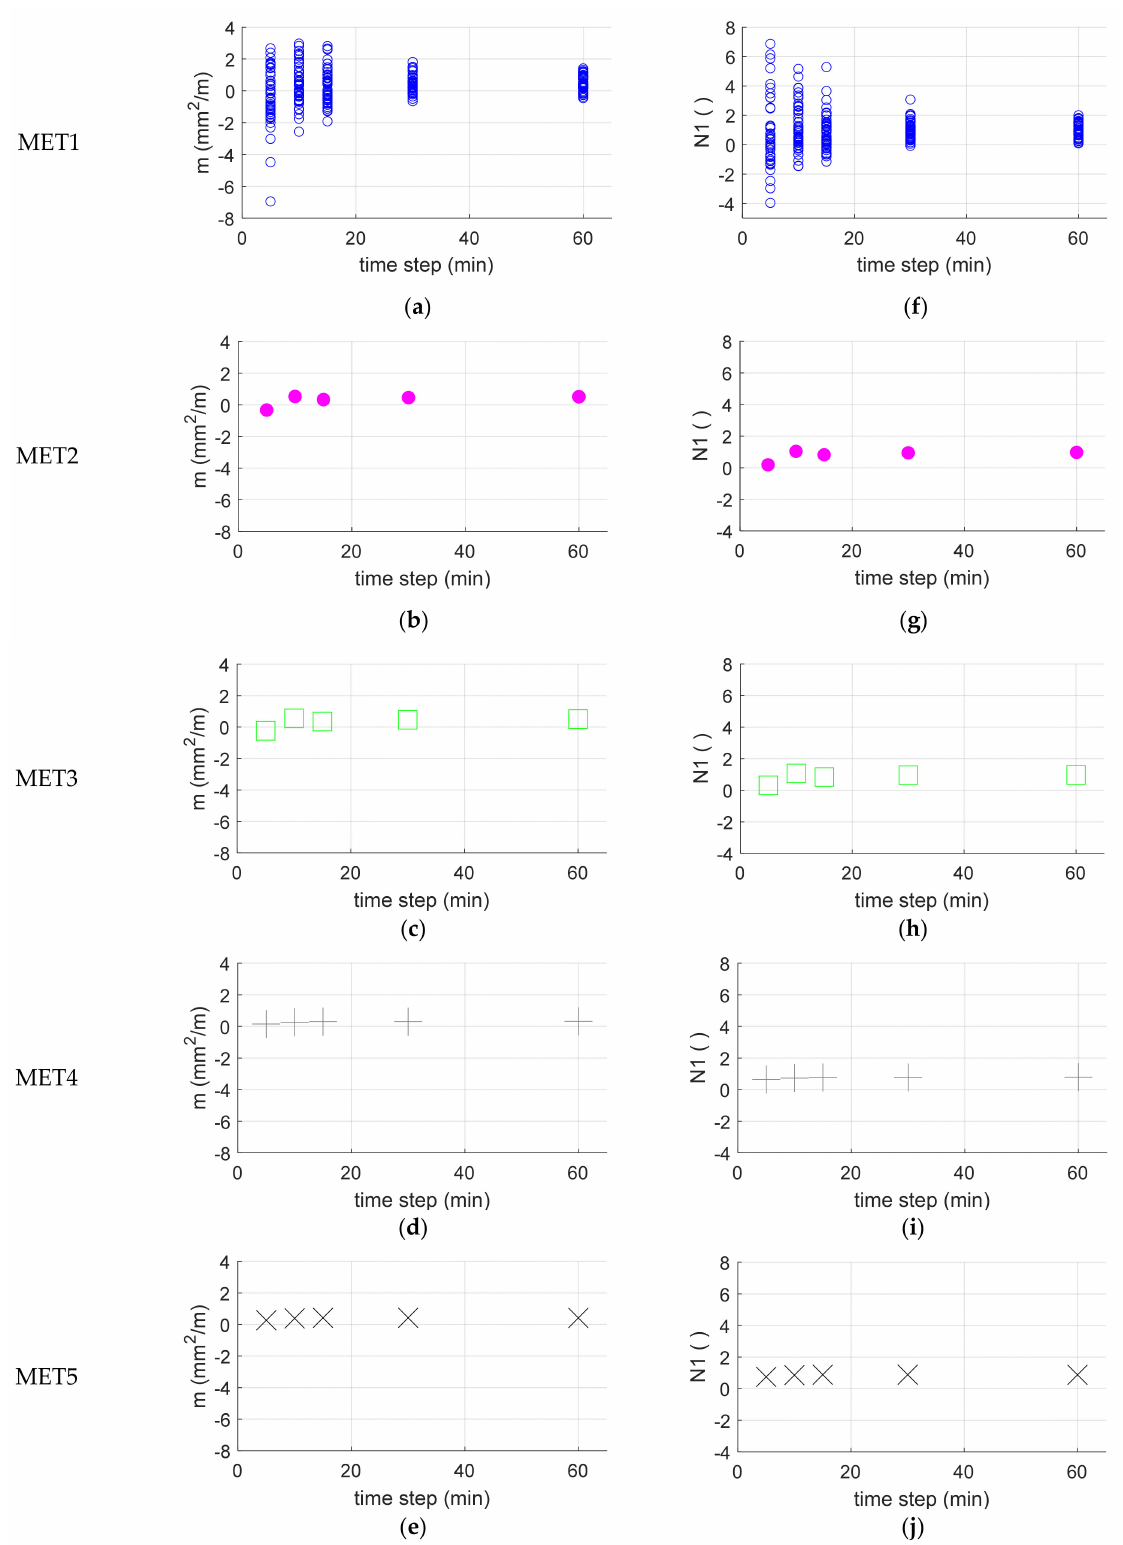
Figure 7. ( a – e ) Values of the coefficient m plotted as a function of the time step estimated with the different methods: MET1–MET5. ( f – j ) Values of the coefficient N 1 plotted as a function of the time step estimated with the same methods. The coefficients estimated with methods MET2 and MET3, i.e., using the averaged pairs and the least squares method with all pairs, still present negative values when